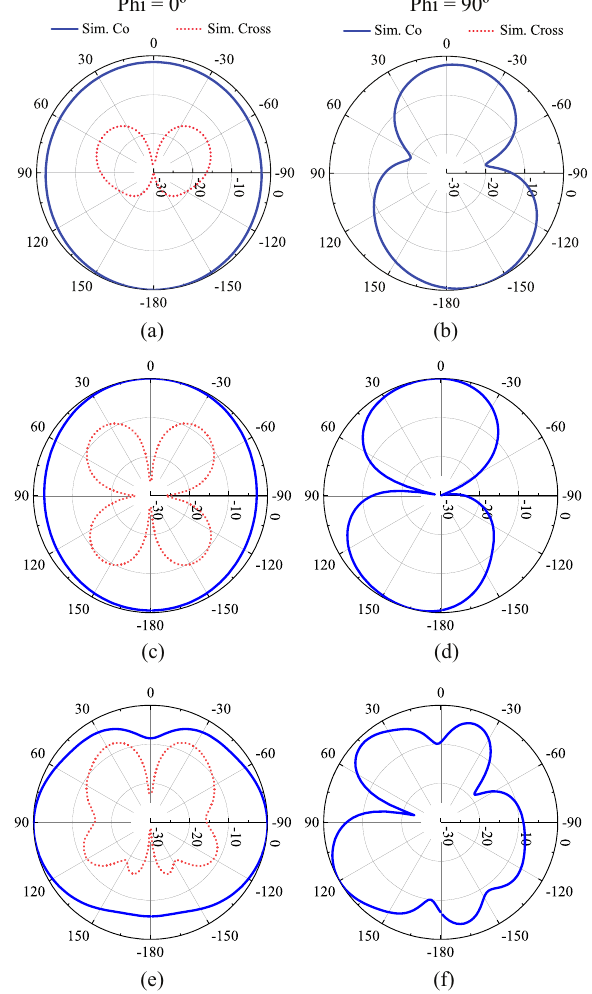
FIGURE 8: 2D radiation patterns of phi= 0 ◦ and 90 ◦ planes at: (a)-(b) 3 GHz. (c)-(d) 6 GHz. (e)-(f) 10